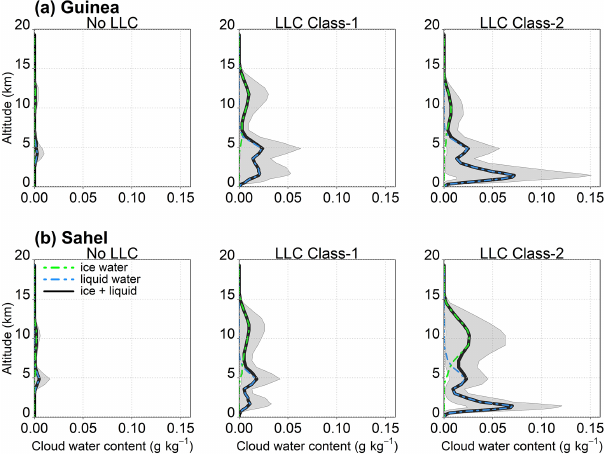
Figure 2. Mean vertical profiles of cloud water content (ice water (dotted green line), liquid water (dotted blue line), and total water content (black line)) during the occurrence of each LLC class in Guinea (a) and the Sahel (b) . Shaded areas refer to the 90th and 10th inter-percentile